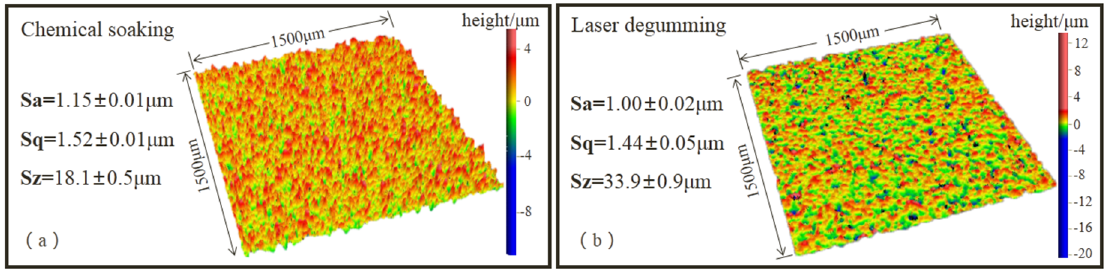
Figure 4. Sample surface roughness processing by chemical soaking ( a ) and laser degumming ( b ).